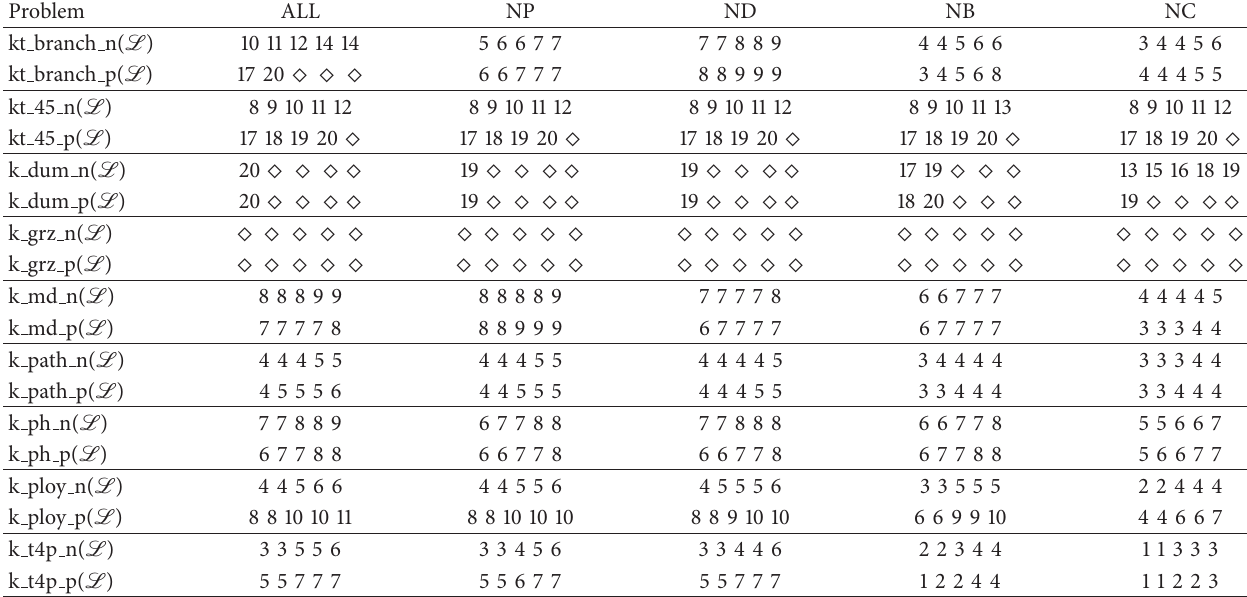
Table 5: Results for KT( L )